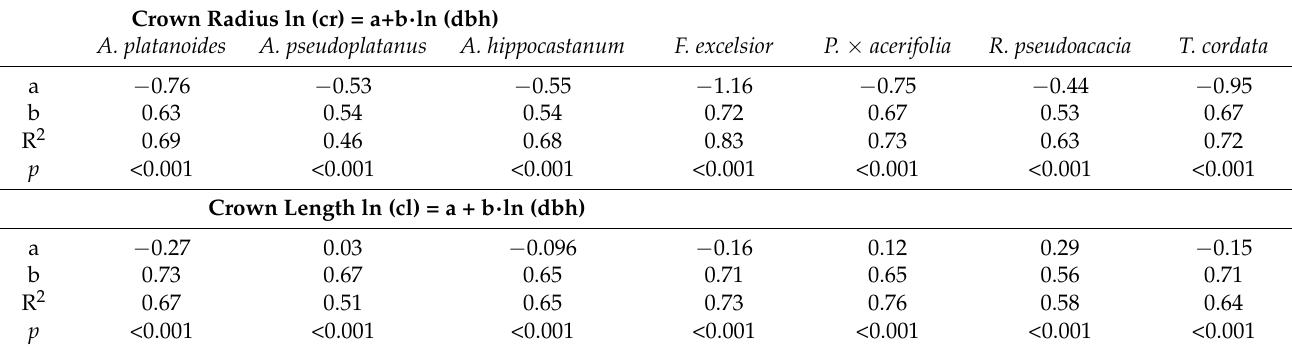
Figure 4. Crown length and diameter at breast height relationship for seven common urban tree species. Table 4. Results of the transformed double-logarithmic equation detecting significance of changes in crown radius and crown length related to changes in dbh. Crown Radius 𝐥𝐧 (𝐜𝐫) = 𝐚 + 𝐛 ∙ 𝐥𝐧 (𝐝𝐛𝐡) A. platanoides